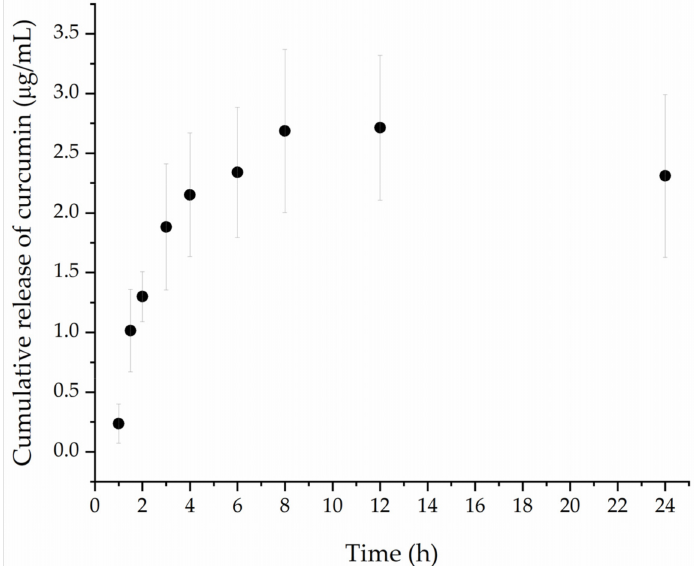
Figure 6. Concentration of curcumin release from PNCDHA nanogel (ug/mL) in PBS-ethanol media under 37 ◦ C.